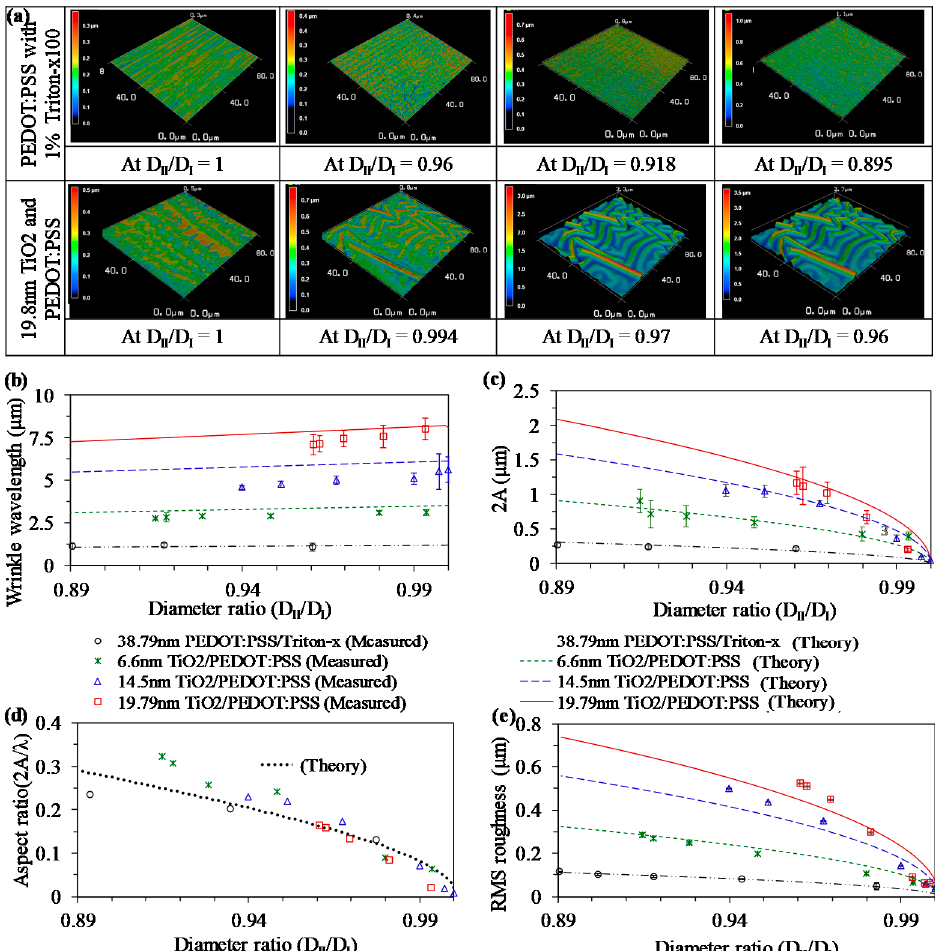
Figure 3. Increase in the wrinkle wavelength and amplitude with the addition of TiO 2 to the poly(3,4-ethylenedioxythiophene) polystyrene sulfonate (PEDOT:PSS) layer. ( a ) Confocal images showing as-deposited and wrinkled states with the progression of the wrinkle formation; plots of wrinkle’s ( b ) wavelength, ( c ) amplitude, ( d ) aspect ratio and ( e ) root mean square (RMS) roughness vs. electrode diameter ratio at increasing compression strain; the theoretical results are based on Equations (S.18)–(S.20).